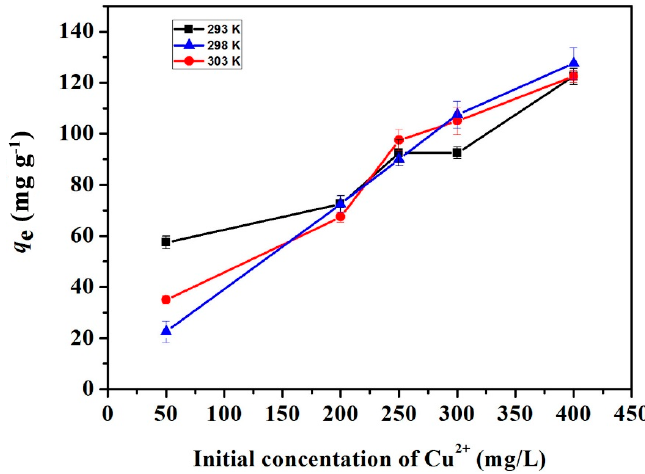
Figure 10. Adsorption of Cu 2+ on the GO(20)/cellulose(100) hydrogel as a function of Cu 2+ concentration. The error bars represent standard deviations based on three measurements.